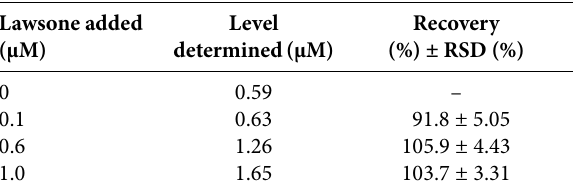
Table 2 Results of the recovery analysis of lawsone (the average of three independent analysis of each spiked sample) in the sample of the commercial henna samples.